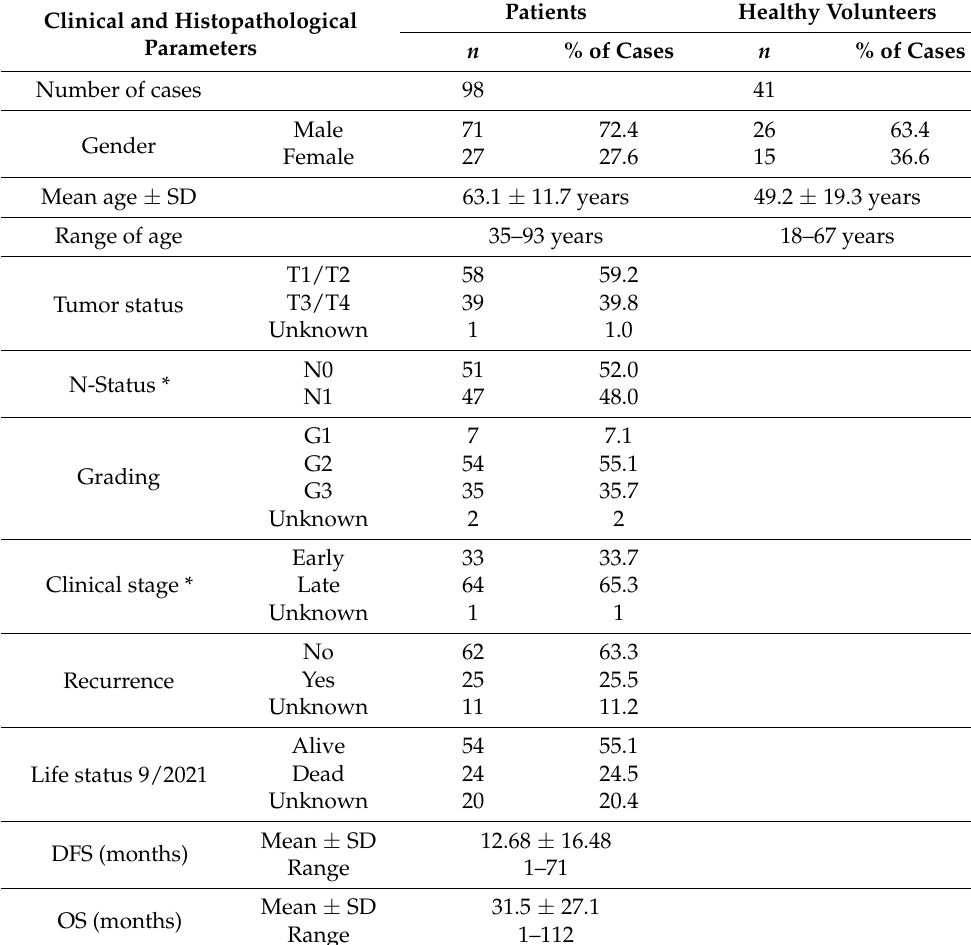
Table 2. Description of the study collective. Total number of cases: 139. * Grouped. The two groups of the collective were gender-matched ( p = 0.27) but not age-matched ( p = 0.01). DFS = disease-free survival; OS = overall survival. Patients Healthy Volunteers Clinical and Histopathological Parameters n % of Cases n % of Cases Number of